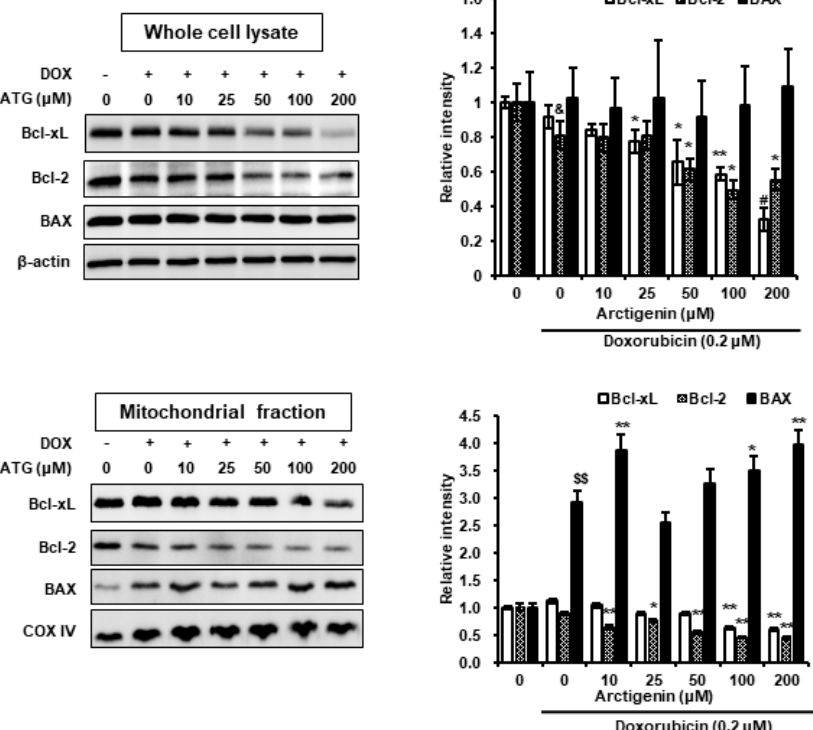
Figure 3. Effects of ATG/DOX co-treatment on mitochondrial Bcl-xL, B-cell lymphoma 2 (Bcl-2), and BAX levels in MDA-MB-231 cells. Cells were attached for 24 h and then co-treated with 0.2 μ M DOX and various concentrations of ATG (0–200 μ M) for 72 h in DMEM supplemented with 2% FBS. ATG/DOX co-treatment reduced Bcl-xL and Bcl-2 levels in whole cell lysate and mitochondria. In contrast, mitochondrial BAX was increased by ATG/DOX co-treatment. The proteins in whole cell lysates and mitochondrial fractions were separated by 15% SDS-PAGE and transferred to PVDF membranes. β -Actin and mitochondrial cytochrome c oxidase subunit IV (COX IV) were used as internal controls in whole cell lysates and mitochondrial fractions, respectively. All bands were densitometrically analyzed using Scion Image and band densities in samples were normalized versus β -actin and COX IV, respectively. & and $$ indicate p < 0.05 and p < 0.005 vs. non-treated controls. *, ** and # indicate p < 0.05, p < 0.01, and p < 0.001 vs. DOX treated cells. Experiments were conducted independently three times and results are presented as means ± SDs. –: 0.2 µ M DOX-untreated, + : 0.2 µ M